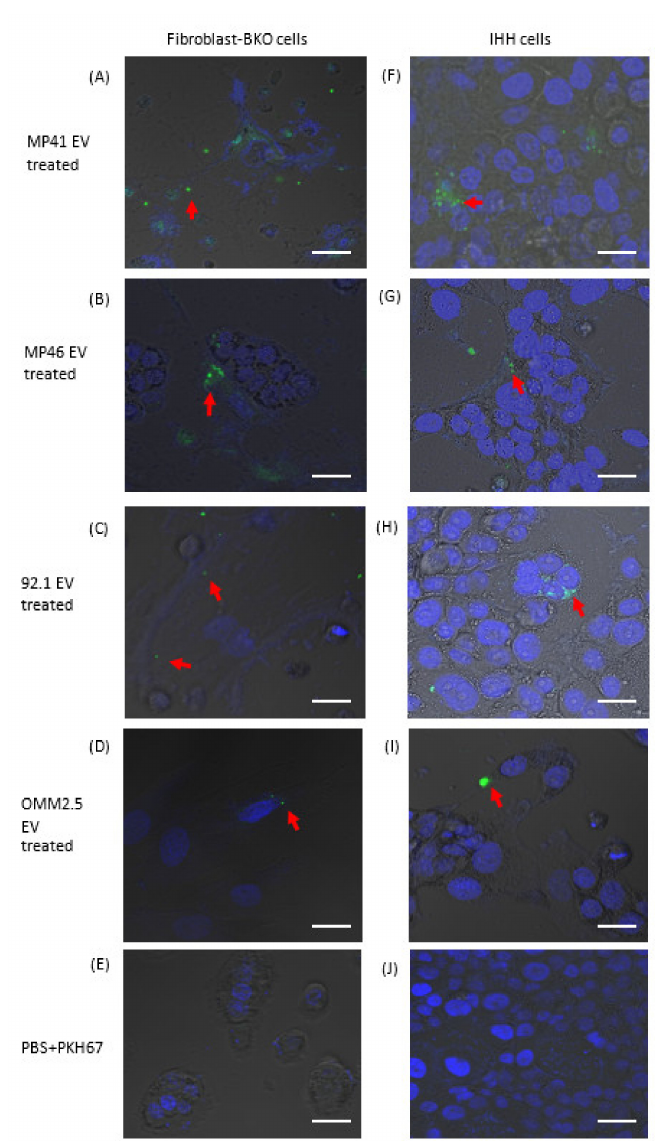
Figure 2. Isolated EVs were e ffi ciently internalized by target cells. EVs from UM cells and NCMs were labeled with PKH67 dye and purified using Optiprep dentity gradient and ultracentrifugation. PKH67-labeled EVs were added to Fibro-BKO cells ( A – D ) and IHH ( F – I ). EV uptake (red arrows) was monitored under confocal microscopy 6 h later. ( E , J ) Cells were exposed to PKH67 solution processed as was the case for labeled EVs. Scale bars 20 µ